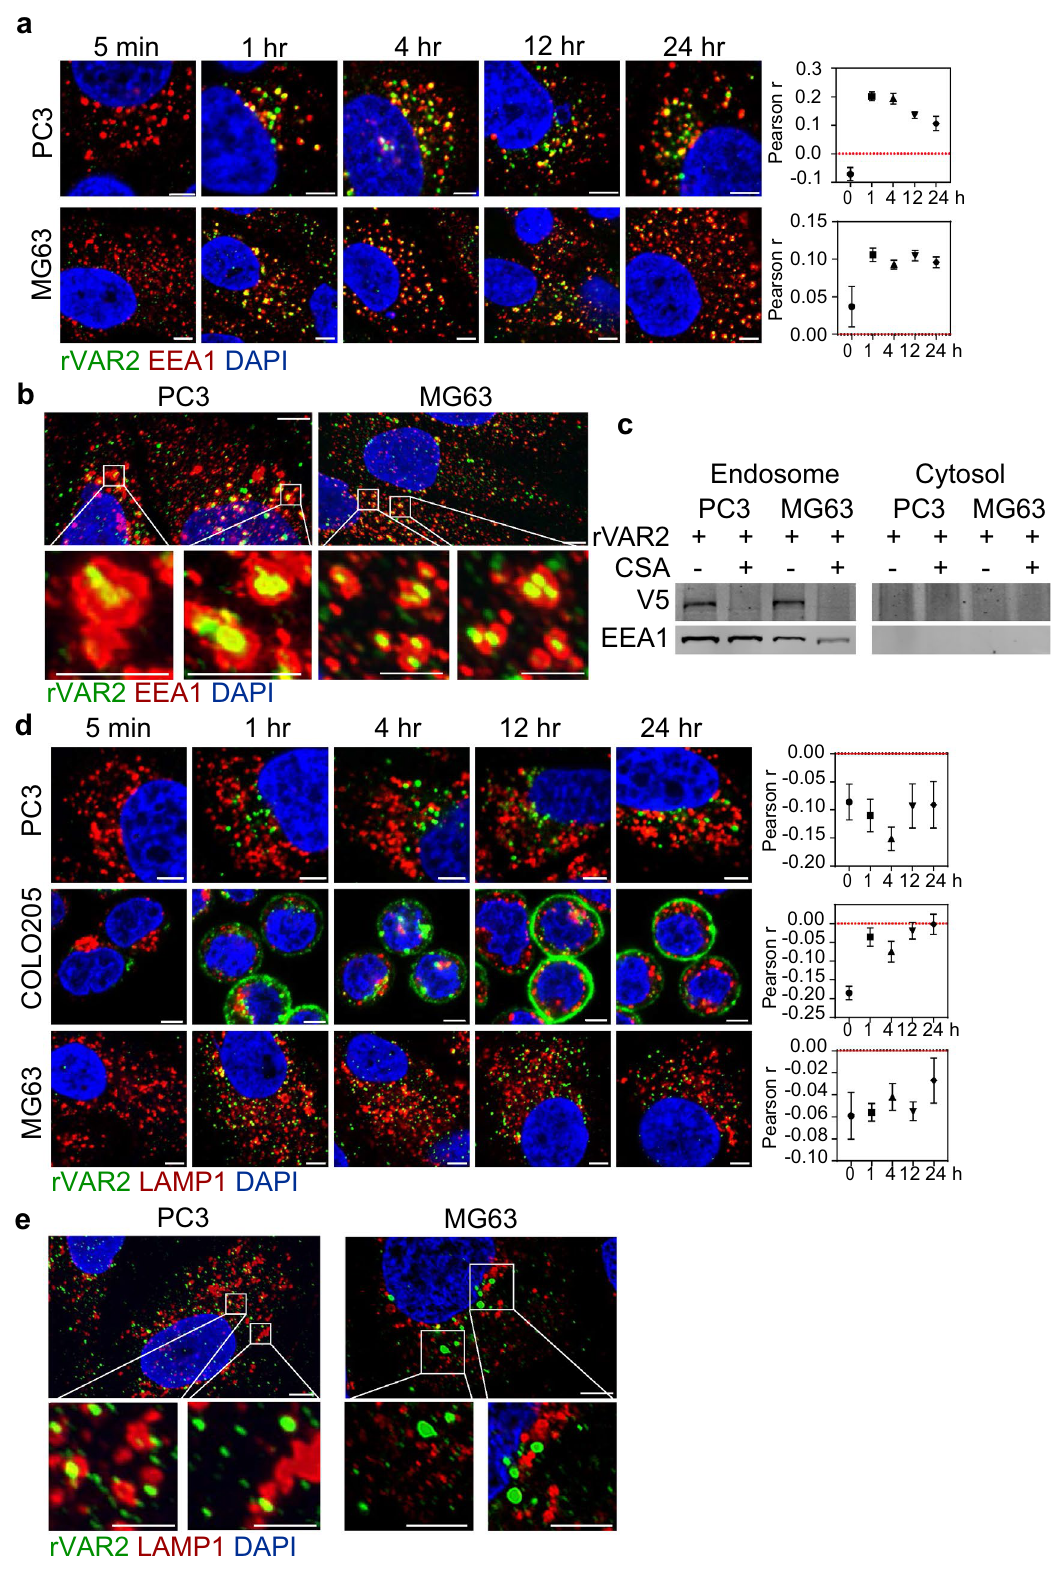
Figure 4. Intracellular trafficking of rVAR2. Confocal images of PC3, COLO205, and MG63 cells stained for rVAR2 and ( a ) EEA1 or ( d ) LAMP1 after rVAR2 incubation at the indicated timepoints. Colocalization was quantified by measuring pearson correlation coefficient of AF488 (rVAR2) and AF594 (markers) signals from confocal images. Values represents the average ± standard error of ≥ 10 images. High resolution images of rVAR2 colocalizing with ( b ) EEA1 or ( e ) LAMP1 were acquired in cells after 4 h of rVAR2 incubation. Scale bar represents 5 µm in large images and 500 nm in small images. (c) Western blot of purified endosome or cytosol by subcellular fractionation in PC3 and MG63